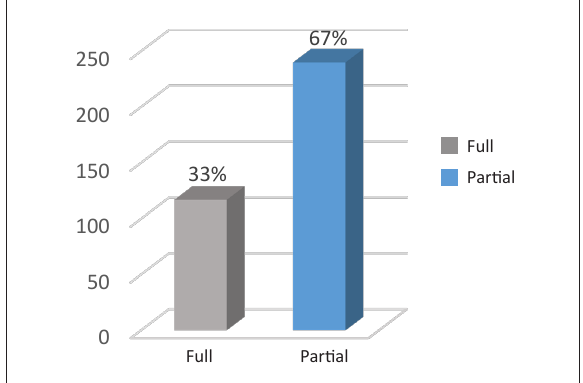
Availability of users’ details.